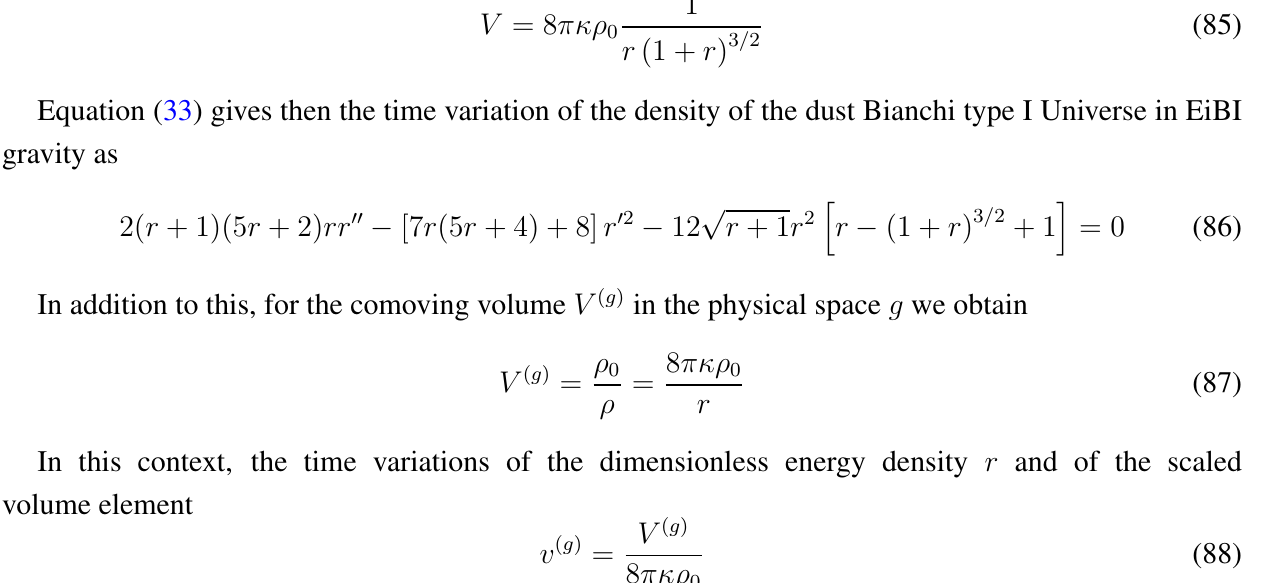
Figure 5. Time variation of the dimensionless matter density r of the dust fluid filled Bianchi type I space-time in EiBI gravity ( left figure) and of the scaled volume element v ( g ) in the physical space g ( right figure), for different initial conditions of the density: r (0) = 0 . 9 (solid curve), r (0) = 0 . 85 (dotted curve), r (0) = 0 . 80 (short dashed curve) and r (0) = 0 . 75 (dashed curve), respectively. In all cases r (cid:48) (0) = − 3